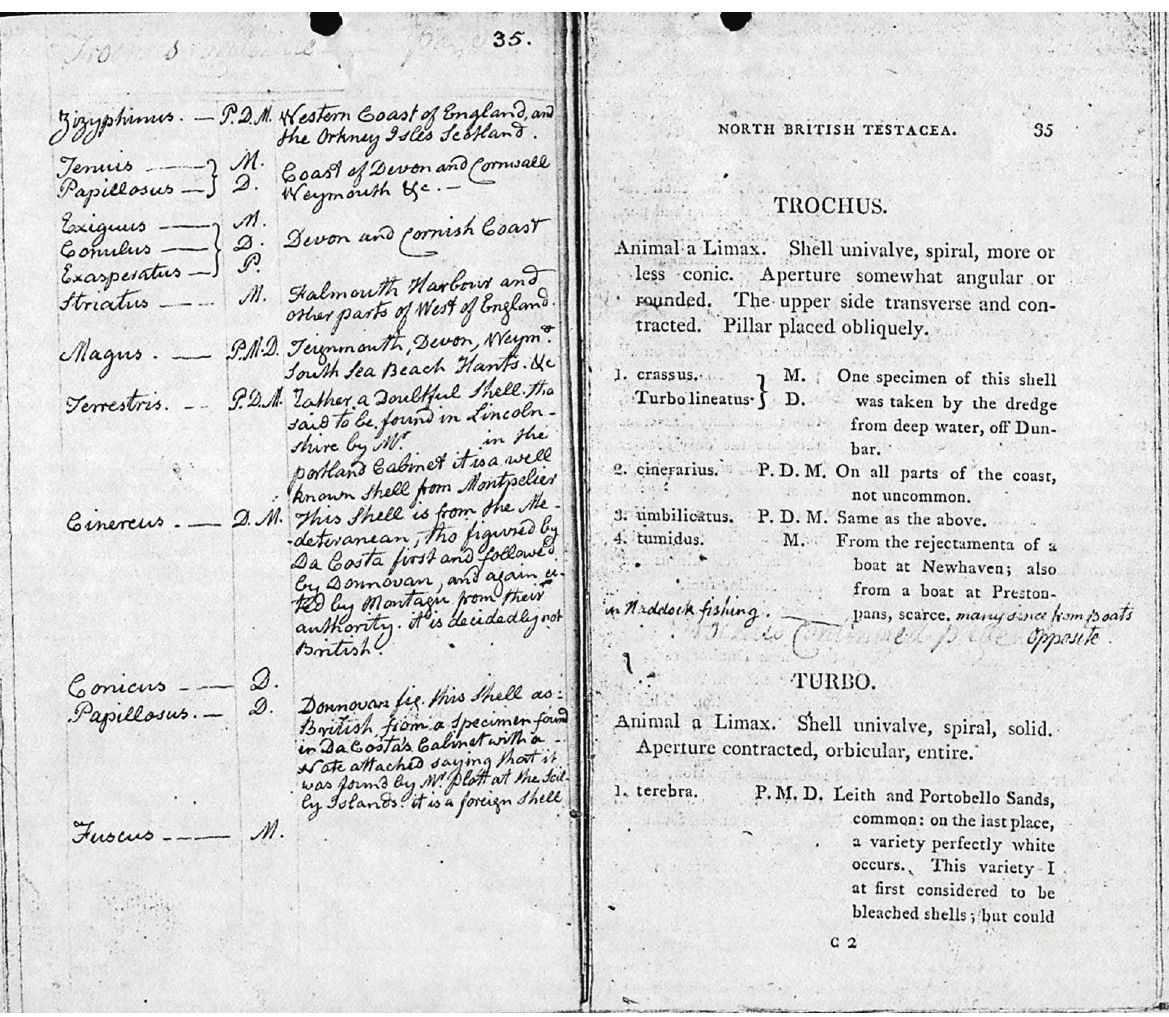
Figure I5. Extract from Laskey’s personally annotated copy of his North British Testacea. Held in the archives of the Mollusca Section of the